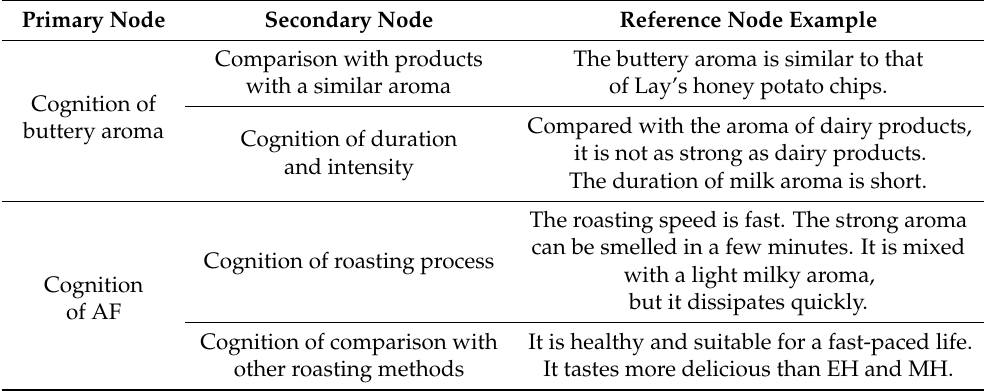
Table 6. Node level and material information of